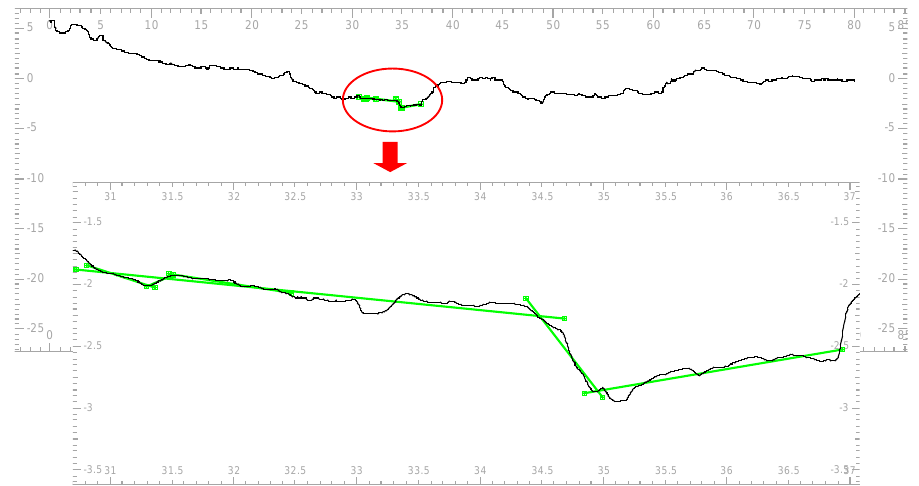
Figure 15. A magnified part of a profile with elements matching the proposed generator marked.